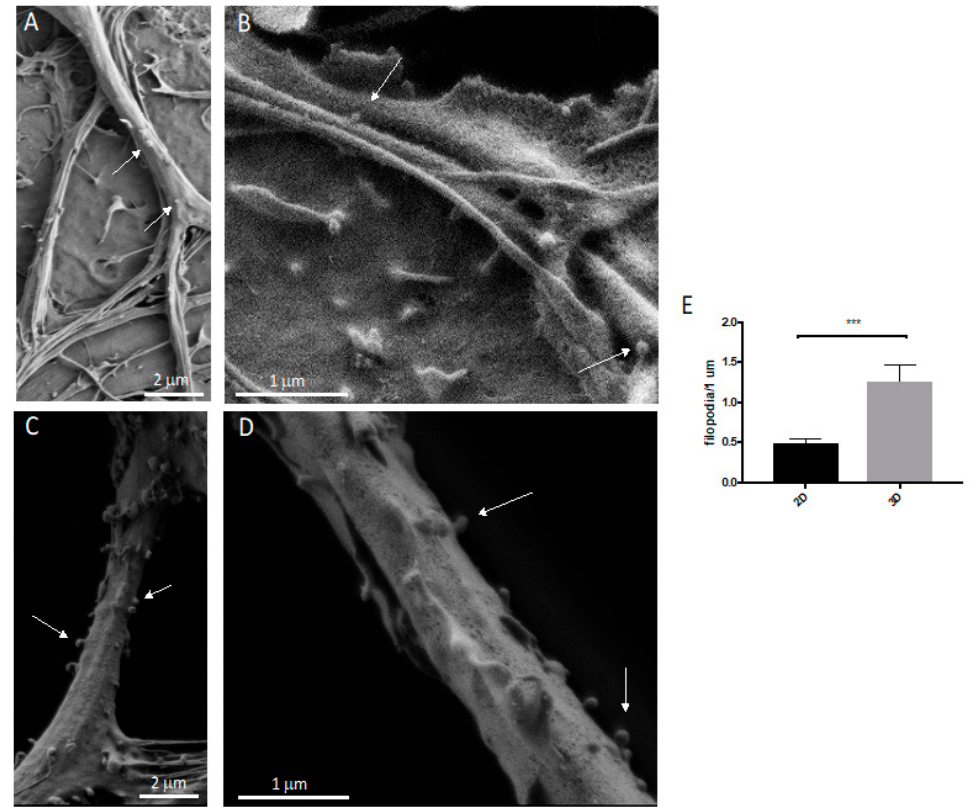
Figure 6. SEM microscopy and protrusion quantification of DIV21 hippocampal neurons co-cultured with astrocytes in 2D and in the 3D synthetic microscaffold Nichoid. ( A ) The 2D hippocampal astrocyte and neuron co-culture. Scale bar of 2 µ m. ( B ) Higher magnification of 2D hippocampal astrocyte and neuron co-culture. Scale bar of 1 µ m. Arrows indicate the protrusions. ( C ) The 3D hippocampal astrocyte and neuron co-culture in the Nichoid. Scale bar of 2 µ m. ( D ) Higher magnification of 3D hippocampal astrocyte and neuron co-culture in the Nichoid. Scale bar of 1 µ m. Arrows indicate examples of filopodia that were considered in the quantification. ( E ) Results of filopodia counts. Conditions were compared using t -tests. Statistical significance: *** p < 0.001. Data are the means ± SEM of 20 dendrites from three independent conditions.